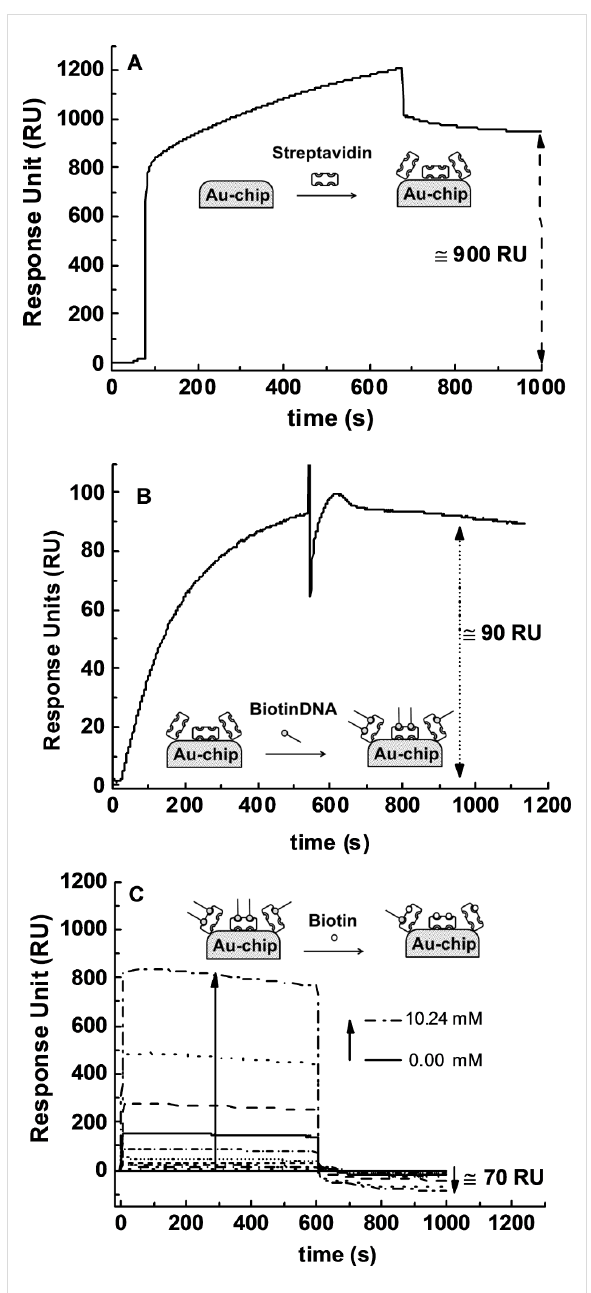
Figure 6: SPR data showing the competitive displacement of BiotinDNA by free biotin. (A) Streptavidin covalent immobilization on gold chip. (B) Streptavidin-BiotinDNA complex formation. (C) Competi- tive displacement of BiotinDNA by the interaction of increasing amount of free-biotin with surface-immobilized